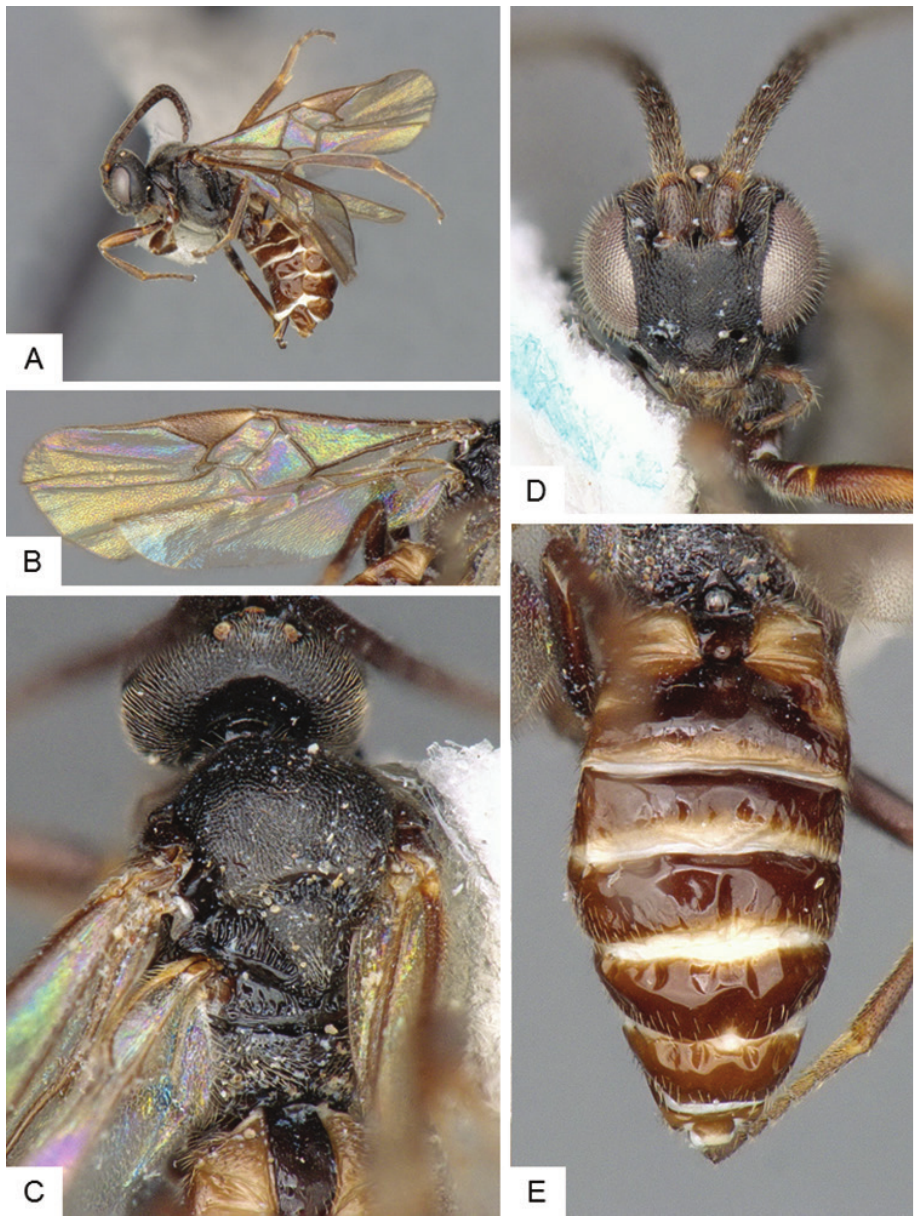
Figure 25. Microplitis coactus . A Habitus, lateral B Fore wing C Head and mesosoma, dorsal D Head, frontal E Metasoma,